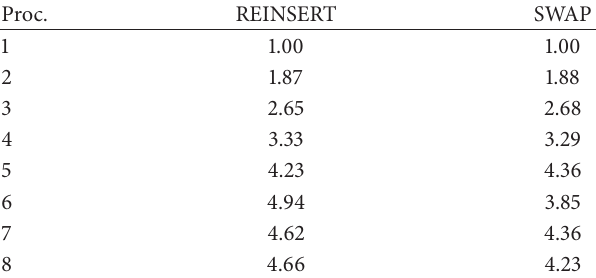
Table 13: PTS and JTS speed-up: random start.